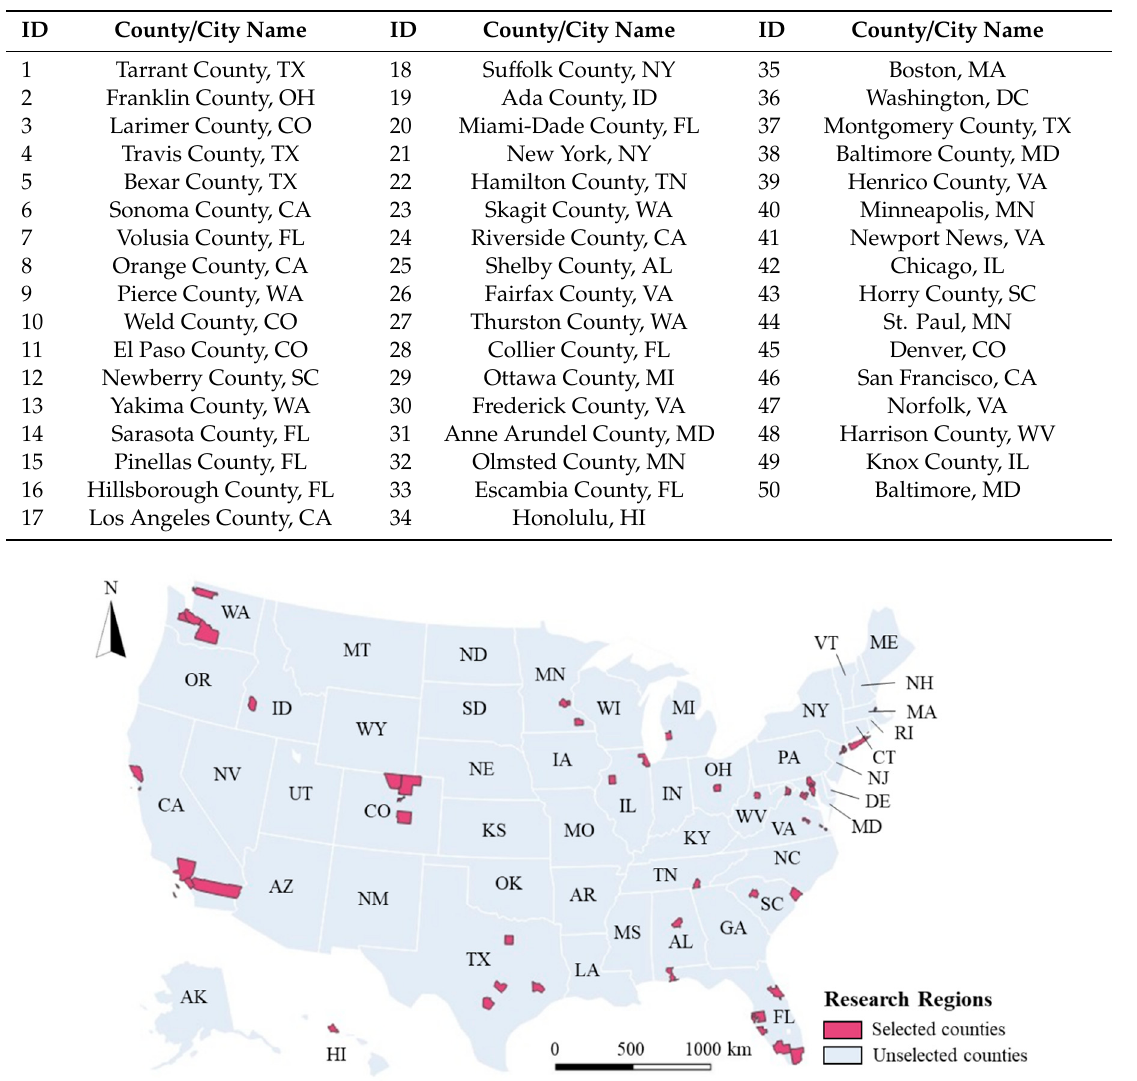
Table 1. Selected 50 counties / cities list from the SpotCrime website.